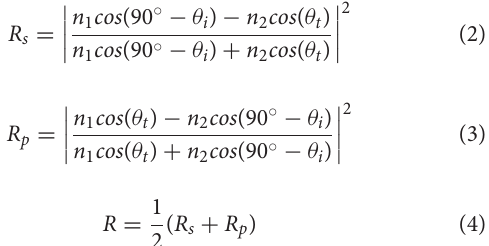
Figure 6 shows the PAR λ 6 as a function of plane angle θ surf . From this we see that the optimum plane angle is θ surf ≈ 47 ◦ relative to the horizon (for a conical frustum shaped cultivation system), which gives the highest direct PAR for the given sun angle. This angle results in PAR of ∼ 625 µ mol m − 2 s − 1 , so the optimally angled plane, as expected, receives a higher light input than a horizontal plane. However, this is only true for the part of the plant facing toward the sun. Assuming that the cultivation plant rotates with a constant speed, we can estimate the average PAR, λ 6 . Figure 7 illustrates the irradiance on a plane as it rotates away from the light source. The diffuse irradiance is equal through the circumference, while the amount of direct radiance decreases as the plant rotates away. To calculate this reduction of direct PAR, the reduction of the light opening is calculated for every degree of rotation and then multiplied with the direct PAR at zero rotation. The distribution of PAR as the plant rotates in the interval − 90 to 90 ◦ is presented in Figure 8 ; for greater rotations only diffuse irradiance reaches the angled surface. Averaging over the whole circle, we get λ 6